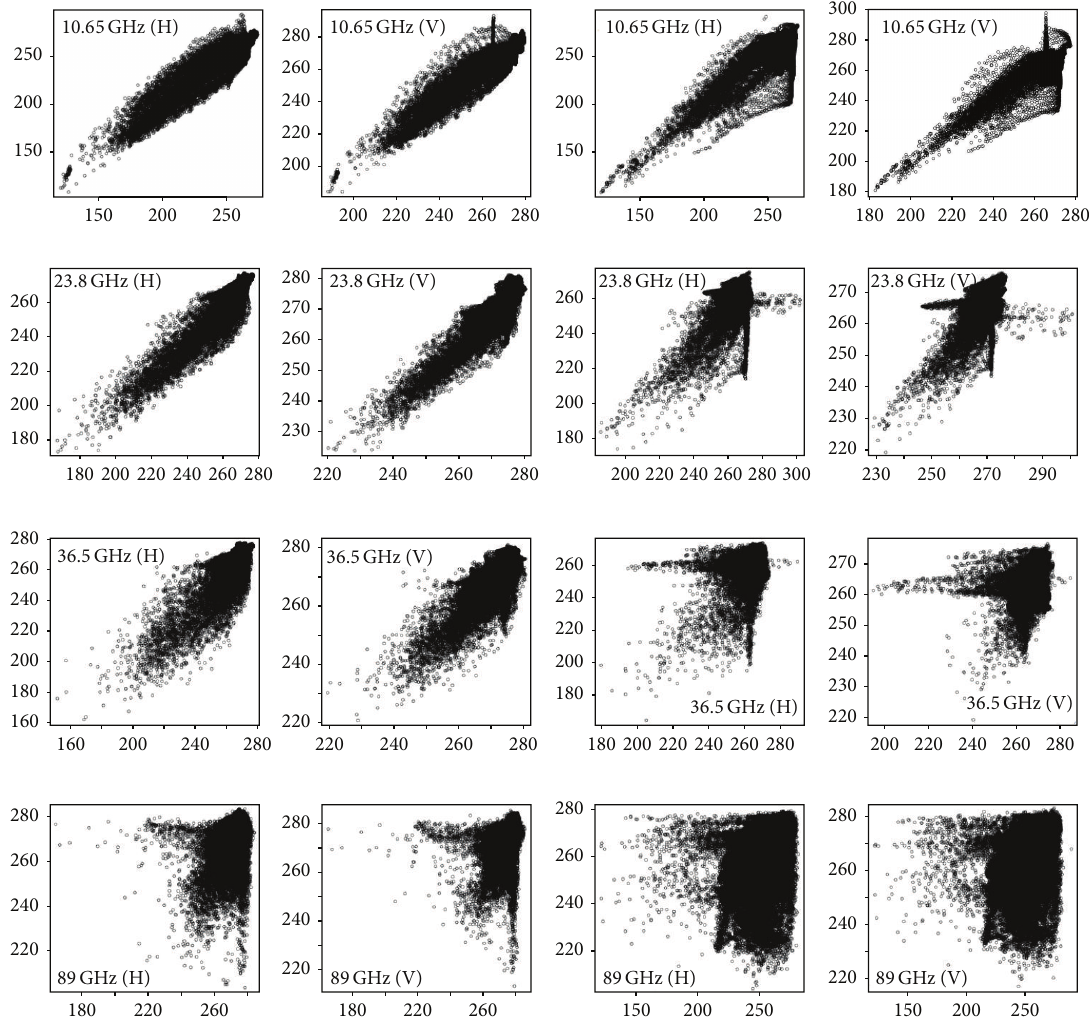
Figure 8: Case of 15 February 2011: scatter plots of SDSU (emissivity table version) against AMSR-E: column 1—horizontal channels clear sky pixels, column 2—vertical channels clear sky pixels, column 3—horizontal channels rainy/cloudy pixels, and column 4—vertical channels rainy/cloudy pixels for all